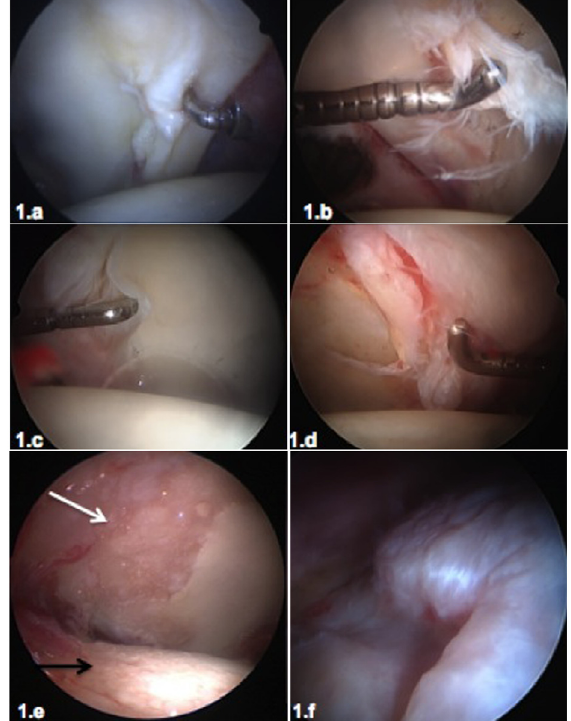
Figure 1. (1a–1d) Overview of arthroscopic progression of chon- dral damage. In early stages of joint damage, a chondro-labral instability (chondromalacia, 1a) occurs in the anterolateral part of the acetabulum. The impact of the femoral bump leads to a disruption at the chondro-labral union (1b) or to degenerative lesions of the labrum. With the progression of the joint damage, chondral flaps were created toward the central area of the acetabulum (1c and 1d). Until these flaps do not reach the load- bearing surface, these damages can be considered early stages of osteoarthritis and satisfactory outcomes with hip arthroscopy can be expected. (1e and 1f) More advanced stages of osteoarthritis lead to thinning and ulceration of the cartilage in the acetabulum load- bearing surface (1e, white arrow), progression of degenerative cartilage damage of the femoral head (1e black arrow), and formation of osteophytes (1f). These advanced lesions should be considered beyond effective treatment with hip